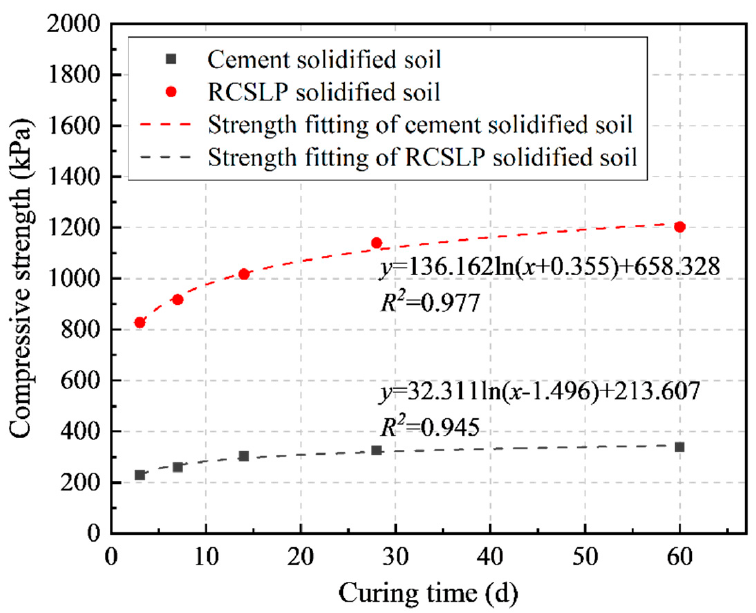
Figure 9. Compressive strength variation of the solidified soil with curing time.